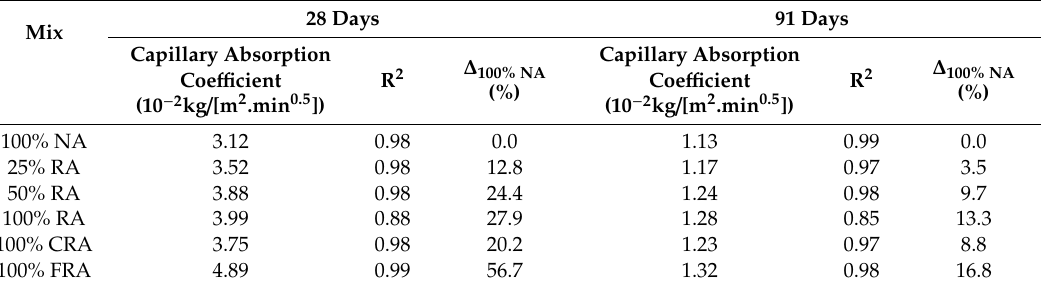
Figure 5. Capillary water absorption results at 91 days. Table 6. Capillary water absorption coe ffi cient at 28 and 91 days.